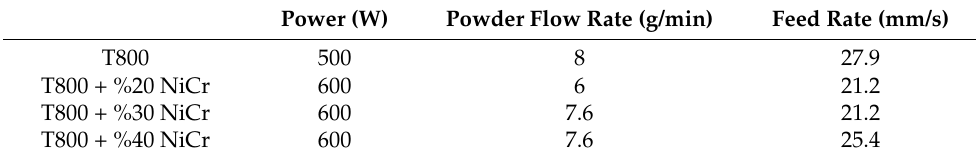
Table 2. Fabrication parameters of T800 and NiCr mixtures by